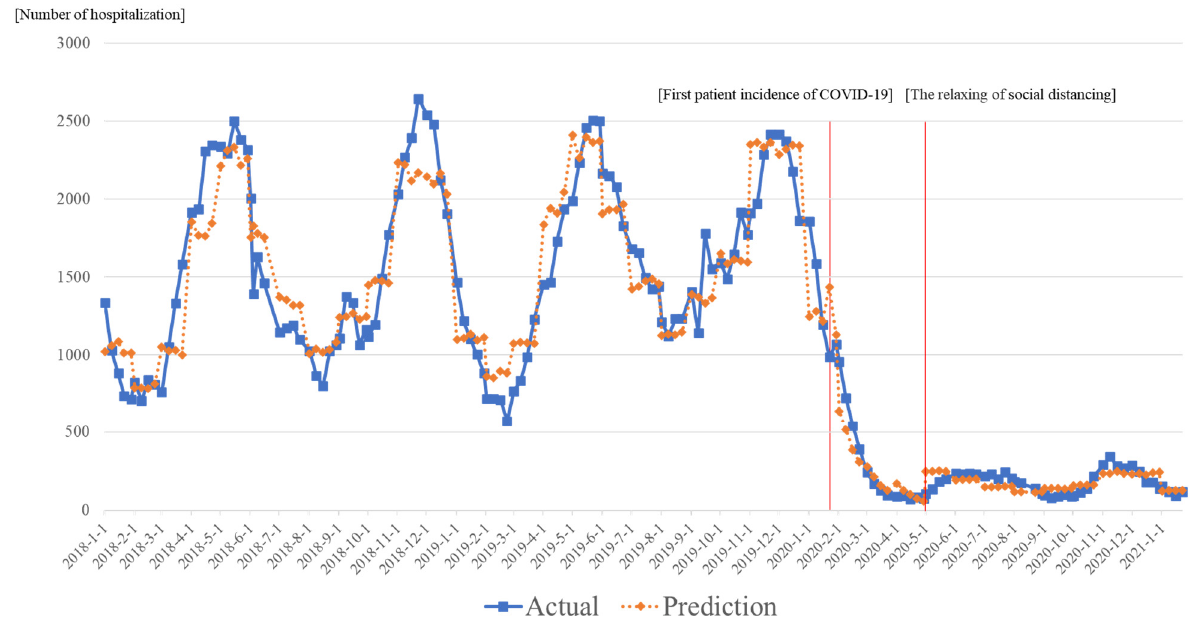
Figure 2. Total actual hospitalization of acute respiratory infection patients and predicted time trends.